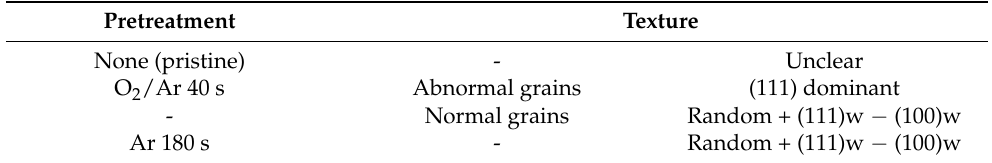
Figure 5. (111) polar plots obtained from Al films deposited on pristine ( a ), O 2 /Ar plasma pretreated ( b ), and Ar plasma-treated polyimide ( c ). Table 1. Summary of texture analyses.